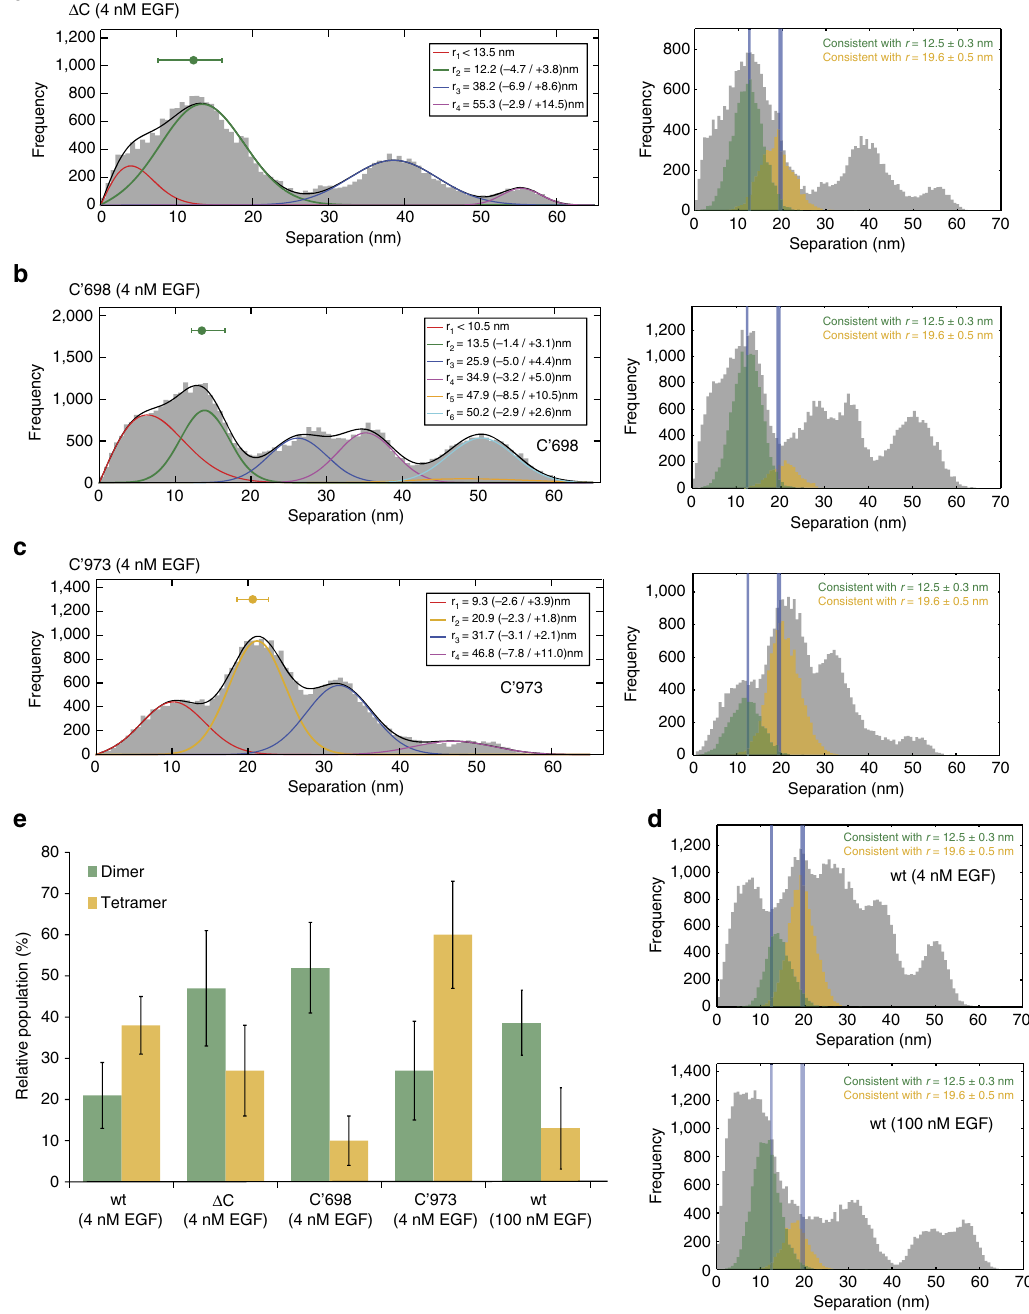
Figure 3 | Pairwise EGF separations in three EGFR deletion mutants. ( a ) (left) FLImP distribution (grey) of pairwise EGF separations on CHO cells expressing D C-EGFR treated with 4nM EGF. The distribution is fitted (black line) with a sum of four Rician peaks (colour lines). The number of peaks used was determined using a Bayesian information criterion. The best-fit positions of the peaks and error bars are shown in the inset. The errors in the fit were calculated as described in Supplementary Methods. (right) The FLImP distribution (grey) and the distributions (green or yellow) compiled from the FLImP measurements whose ranges of 69% confidence overlap with the ranges of EGF separations of the expected dimer (12.5 ± 0.3nm) or tetramer (19.6 ± 0.5nm), which are indicated by the vertical blue lines. ( b ) Similar to a for C’698 EGFR. ( c ) Similar to a for C’973 EGFR. Cells stably expressed each mutant at an expression level of B 10 5 copies per cell. ( d ) Similar to a for the wild-type receptor respectively treated with 4 and 100nM EGF. The numbers of FLImP measurements included in each distribution are 40 ( D C-EGFR), 44 (c’698-EGFR), 33 (c’973-EGFR), 51 (wild type receptor at 4nM EGF), and 37 (wild type receptor at 100nM EGF); the confidence interval for each included FLImP measurement is 6nm ( d ) or 7nm ( a – c ). ( e ) Relative populations of the dimers and the tetramers, determined from the FLImP measurements shown in a – d , right hand panels. For each construct, the dimer percentage is estimated by the ratio of the green integral area to the integral area of all FLImP measurements whose 69% confidence overlaps with the dimer-tetramer region (0–20.1nm). Tetramer populations are calculated in the same way, using the yellow instead of the green integral area. Error bars were calculated by bootstrap-resampling the data 1,000 times with replacement and repeating the analysis.